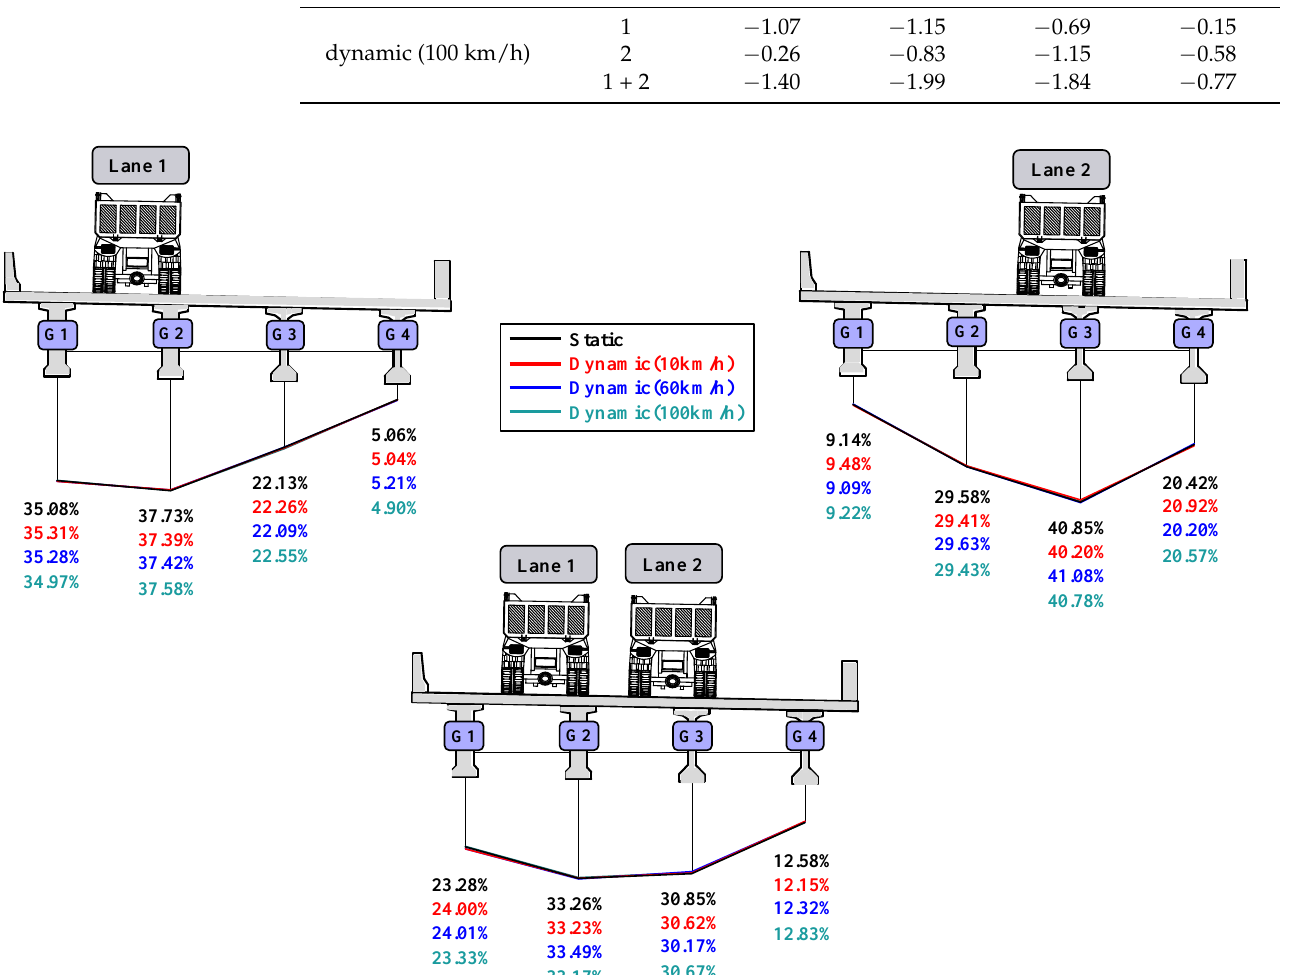
Figure 8. Comparison of LLDF according to the loading position in the vehicle loading test.